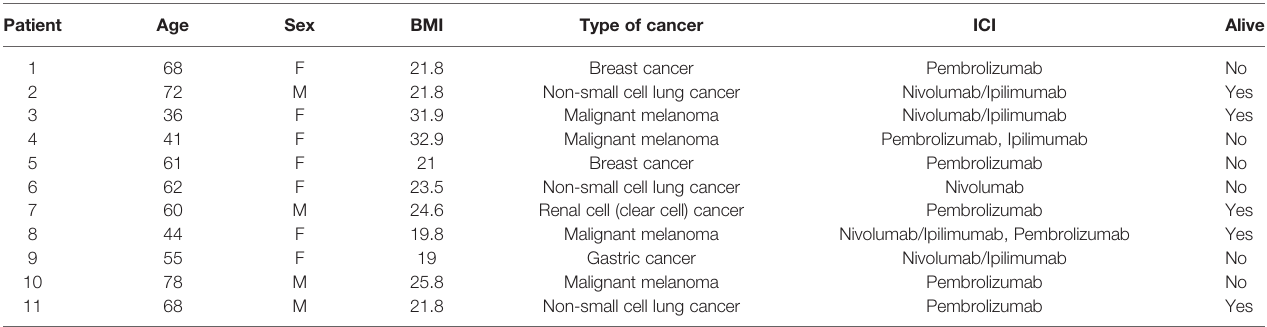
TABLE 1 | Demographic